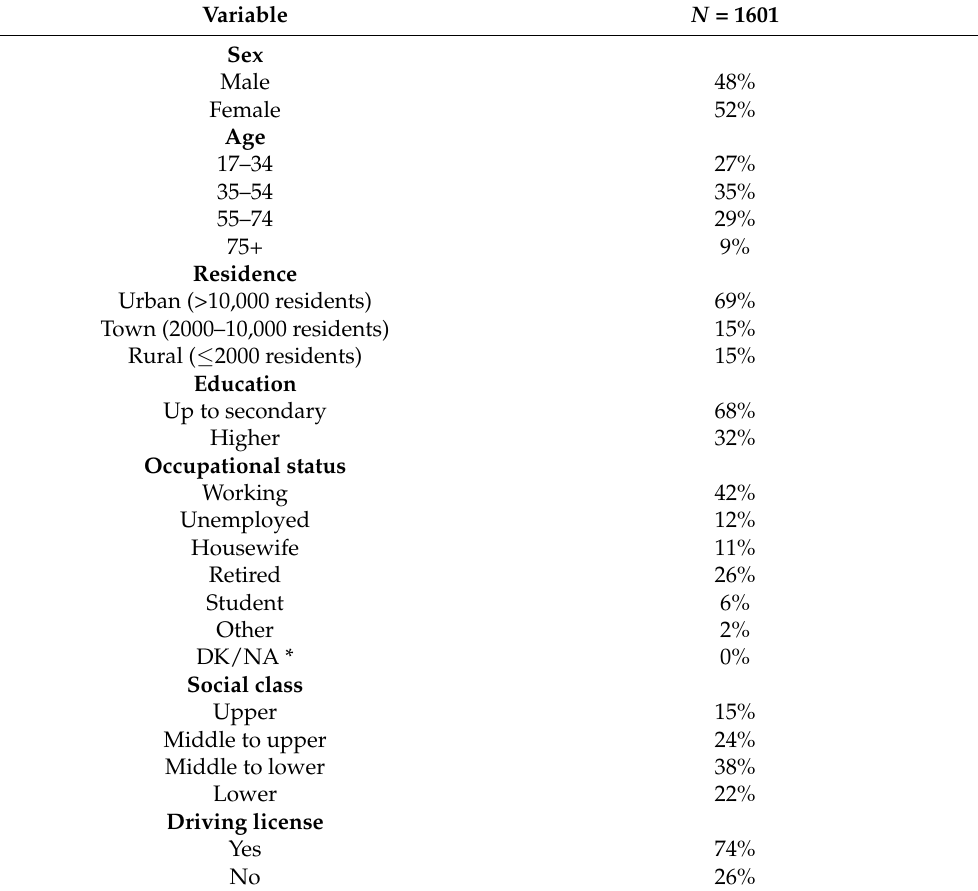
Table 2. Demographic characteristics of study